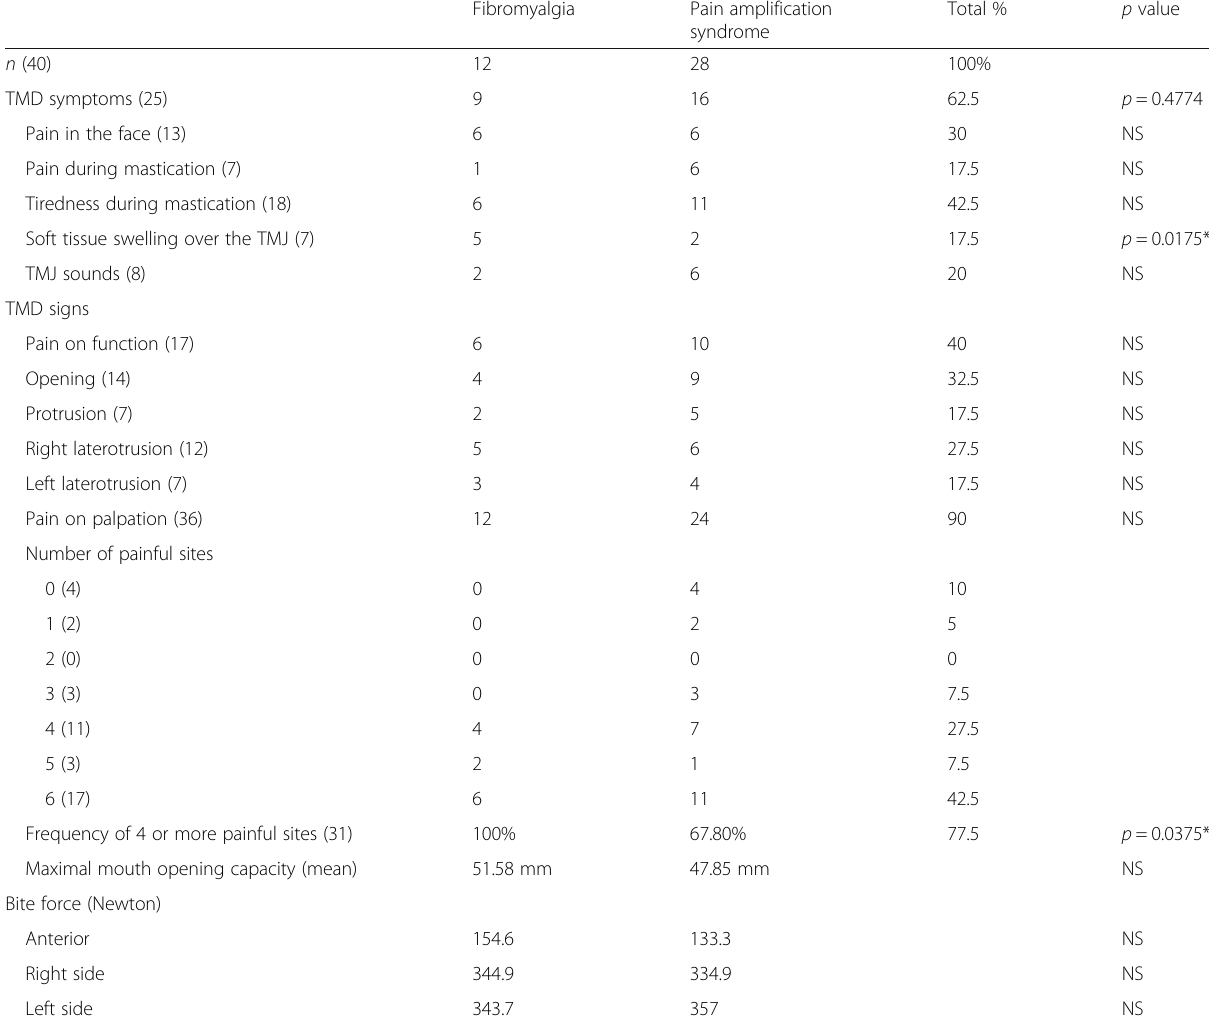
Table 2 Temporomandibular Disorders (TMD) symptoms and signs and bite force measurement between the two pain groups